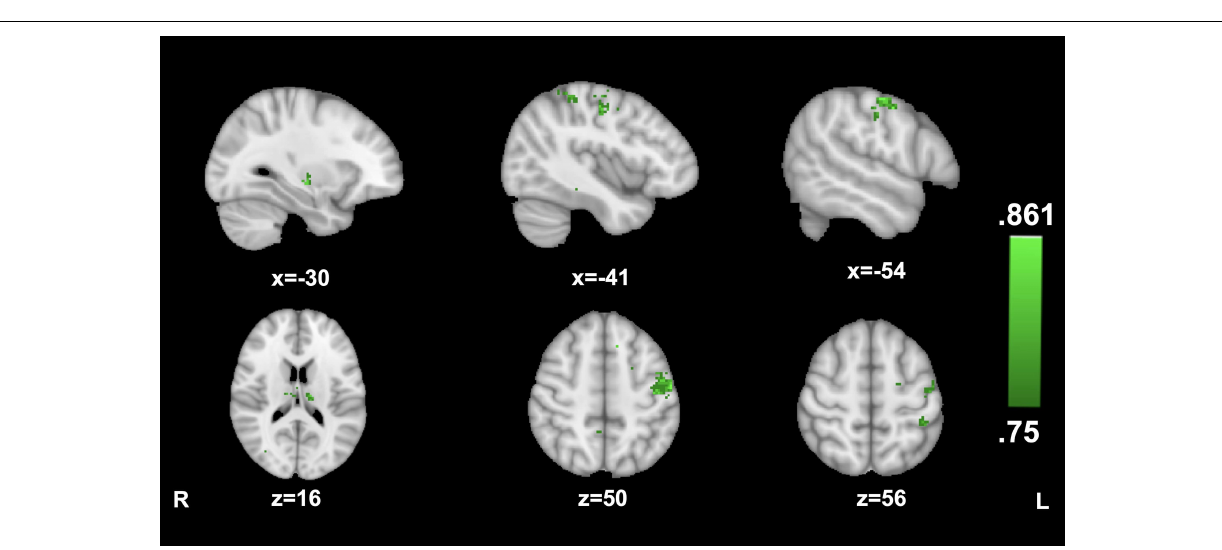
FIGURE 2 | Anterior insula connectivity and narrative transportation during The Hitcher. MVPA searchlight showing above chance classification of AI connectivity maps for high vs. low transportation during the Hitchhiking